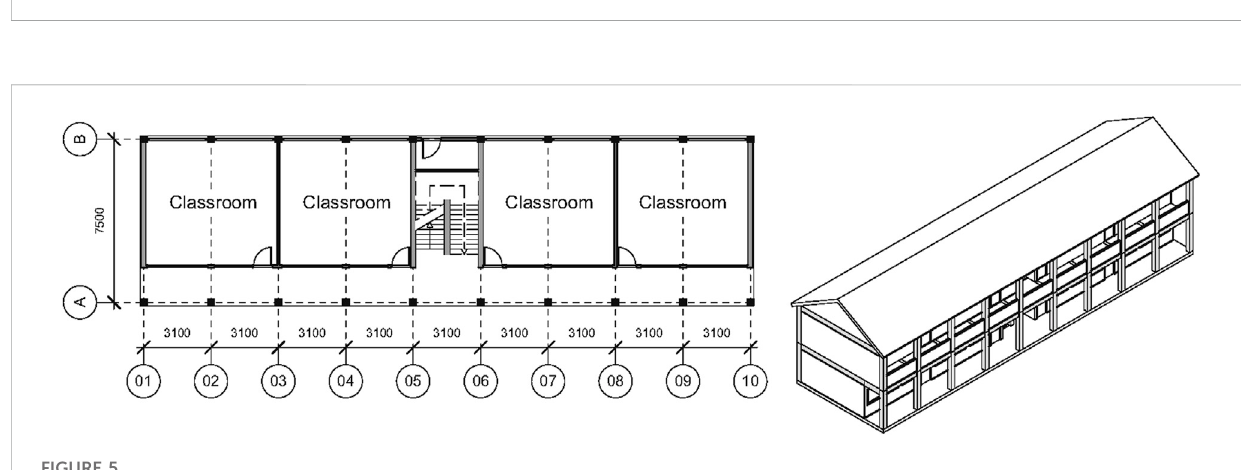
FIGURE 4 Schools exposed to tsunami and schools surveyed; enlarged window of the Ampara district. Data from the DMC, 2012 and Ministry of Education, 2019.